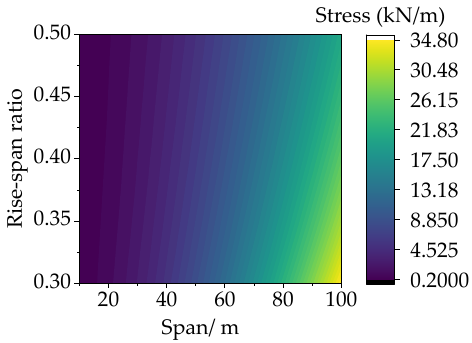
Figure 19. Stress of center weld joint at different spans and rise-span ratios.